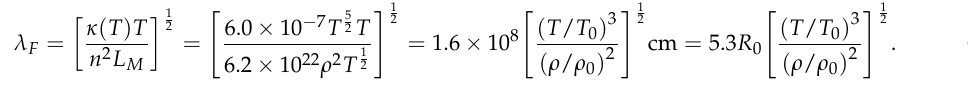
Figure 5. ( a ) Distributions of radiative cooling rate − Q br / Q 0 of Model 2 at t / t 0 = 30. Q 0 = ρ 0 V 03 / R 0 = 5.1 × 10 16 erg/ cm 3 · s is normalization unit. ( b ) Distributions of thermal conduction rate Q hc / Q 0 at t / t 0 = 30.